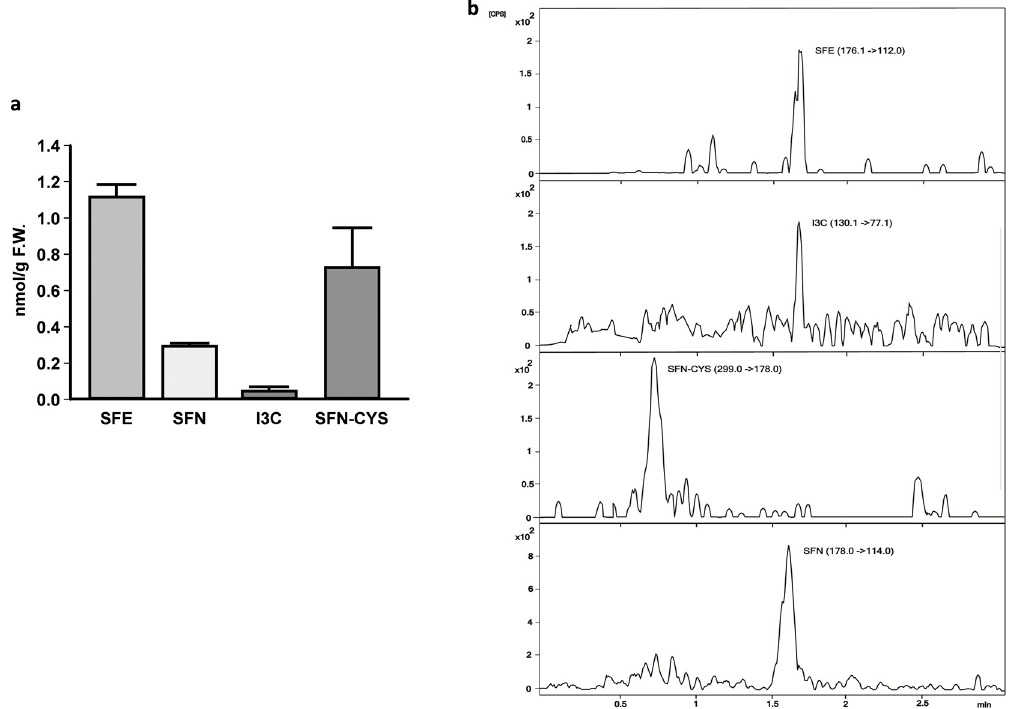
Figure 3. ( a ) Metabolites present in Drosophila melanogaster following the consumption of